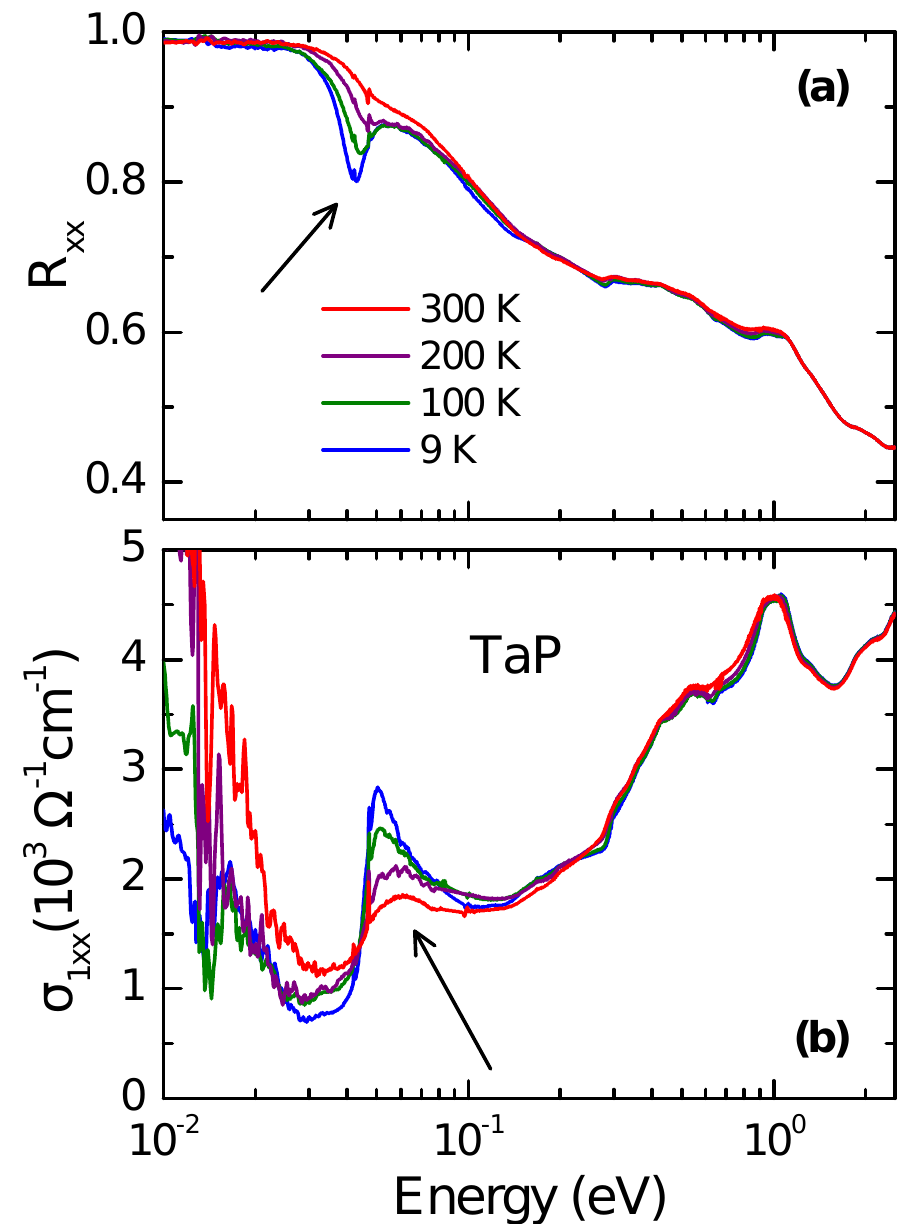
Figure 2. ( a ) Experimental in-plane reflectivity and ( b ) the corresponding real part of the optical conductivity of TaP at selected temperatures [35]. The arrows mark the feature discussed in this paper. The increased σ 1 xx at low energies is due to intraband (Drude-like)